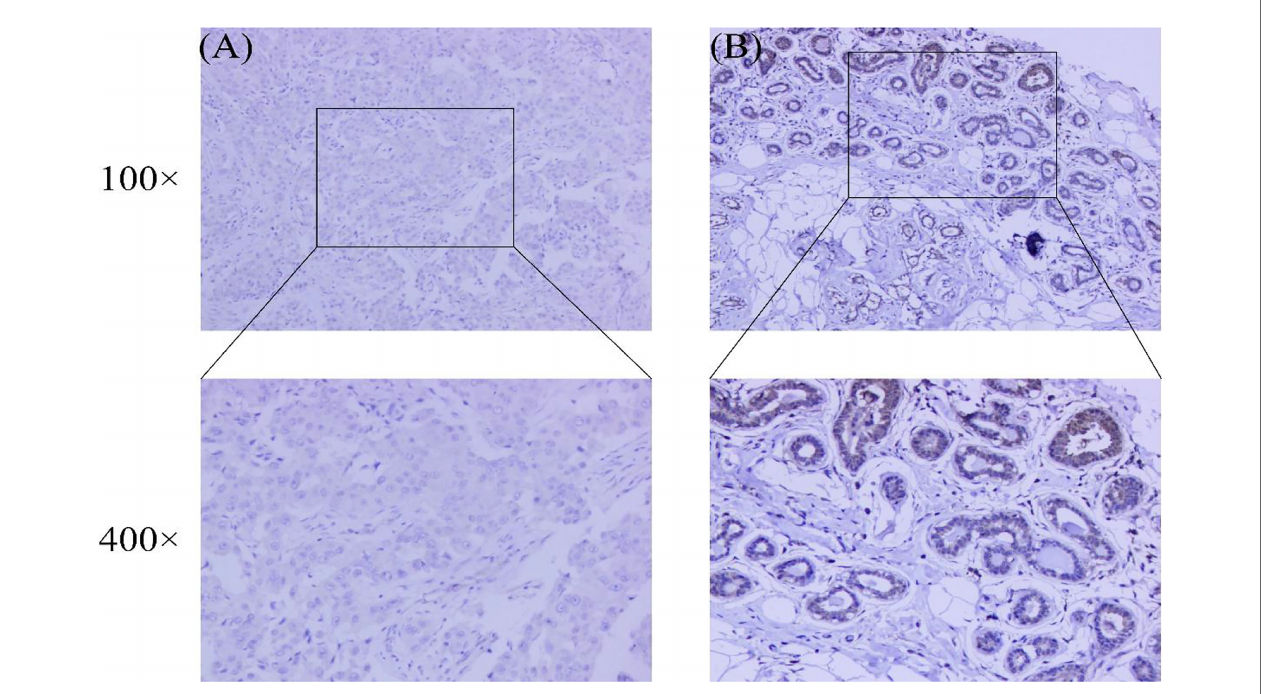
FIGURE 3 | Expression of CRIM1 in 265 breast cancer patient samples and 101 normal breast tissues were examined by immunohistochemistry. (A) CRIM1 expression is negative (-) in breast cancer; (B) CRIM1 expression is moderate (++) in normal breast